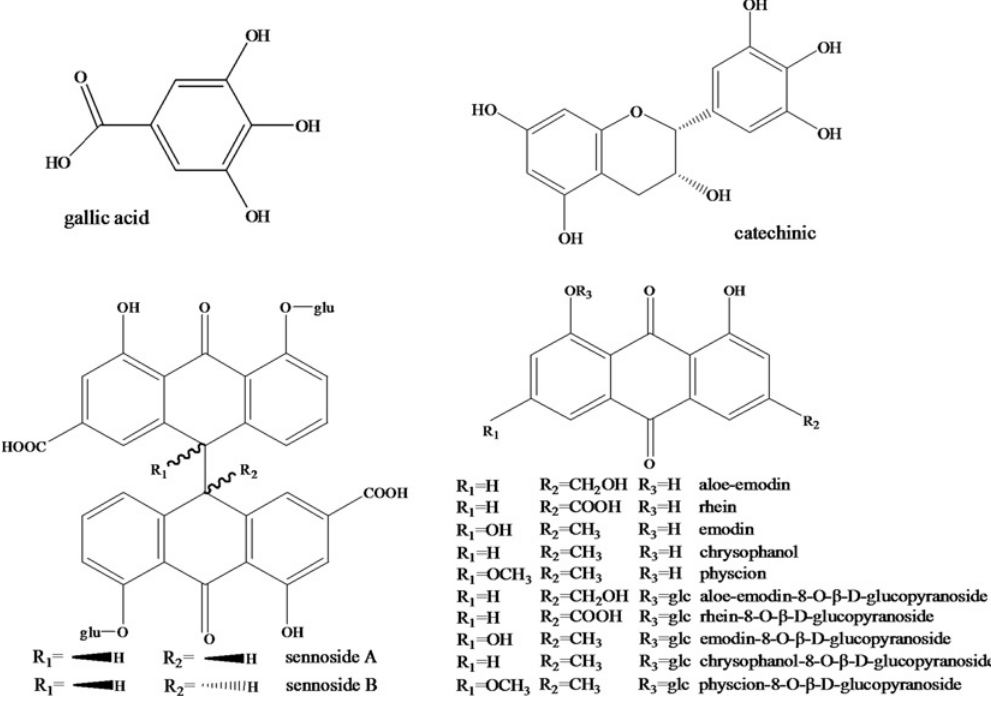
Fig 1. Chemical structures of the 14 active pharmaceutical ingredients (API) of